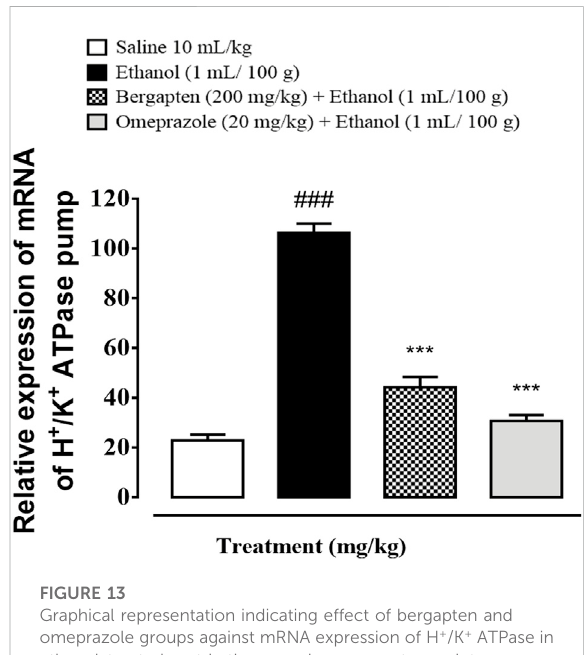
FIGURE 13 Graphical representation indicating effect of bergapten and omeprazole groups against mRNA expression of H + /K + ATPase in ethanol-treated gastric tissues, using reverse transcriptase polymerase chain reaction (RT-PCR) technique. The data are expressed as mean ± SEM ( n = 3). One-way ANOVA with post hoc